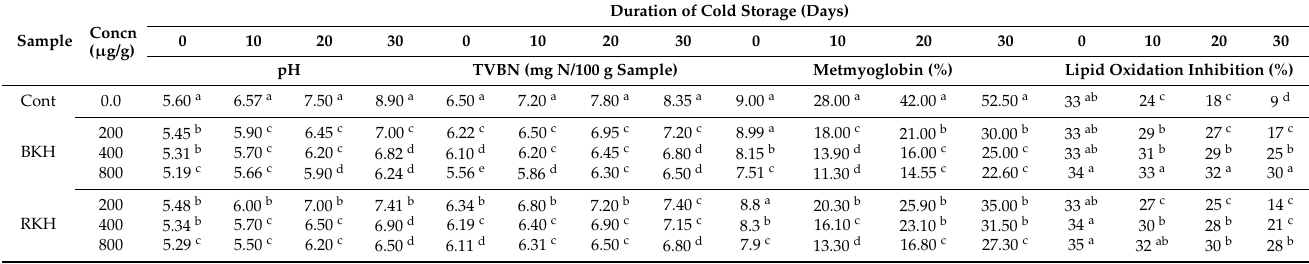
Table 7. Physicochemical changes in raw chicken meat supplemented with black, red, and white kidney bean protein hydrolysate (BKH, RKH, and WKH) obtained by alcalase after 30 min hydrolysis, at 0–30 days cold storage at 4 ◦ C. Duration of Cold Storage Sample Concn ( µ g/g)